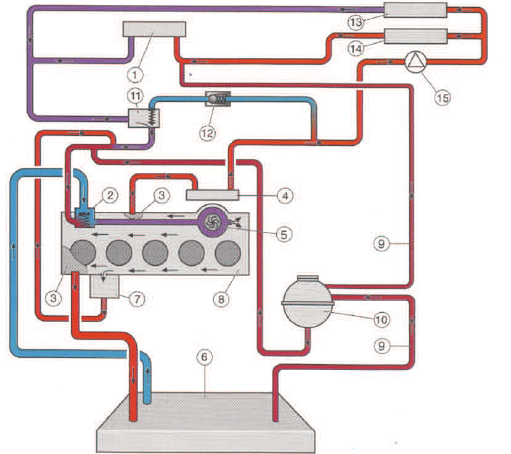
Table 2. The engine data installed on the test bench [8] Built